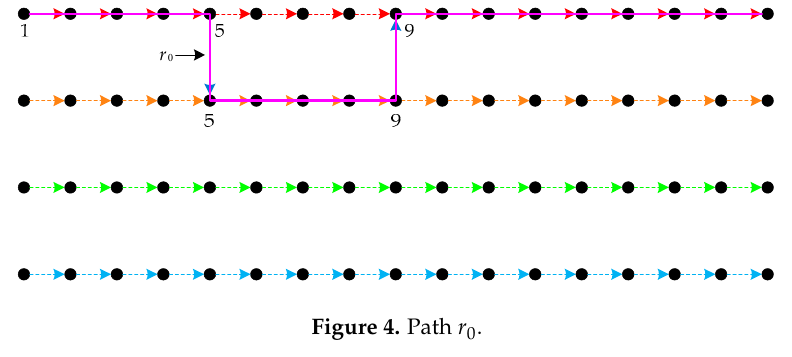
Figure 4. Path r